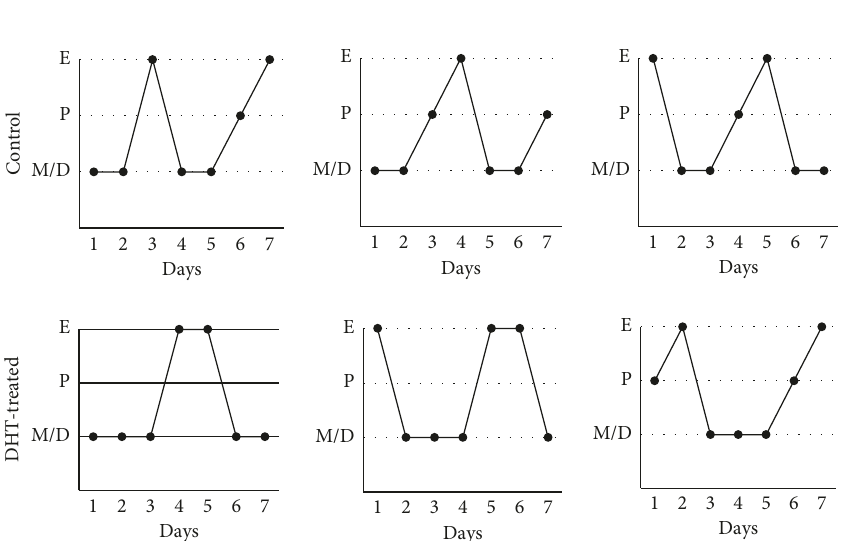
Figure 1: Estrous cyclicity in control and DHT-treated rats. Six-week-old female rats were injected subcutaneously with DHT (5mg/kg/ day) daily. Vaginal smears were collected daily to evaluate estrous cyclicity during treatment. However, DHT-treated rats still showed estrous cyclicity similar to that of control rats. Three representative cycles in control and DHT-treated rats are